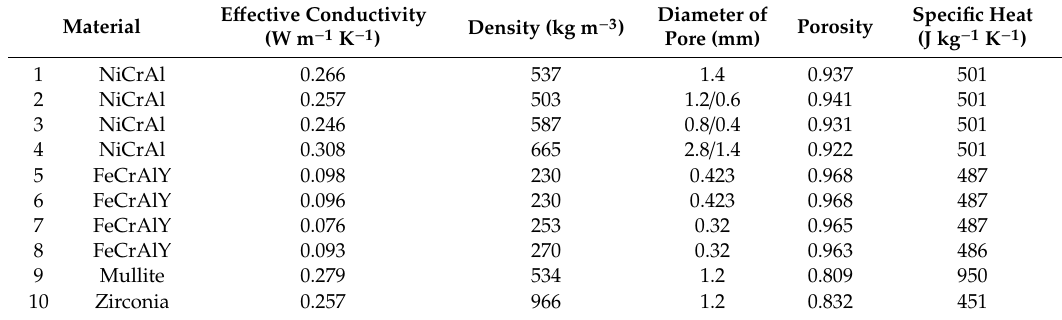
Table 3. Properties of the metallic and ceramic foam samples characterized experimentally [20].